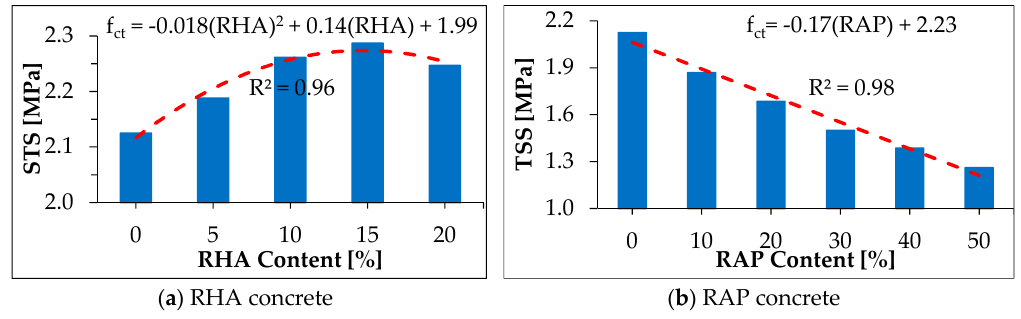
Figure 11. Splitting strength for RHA and RAP concrete.